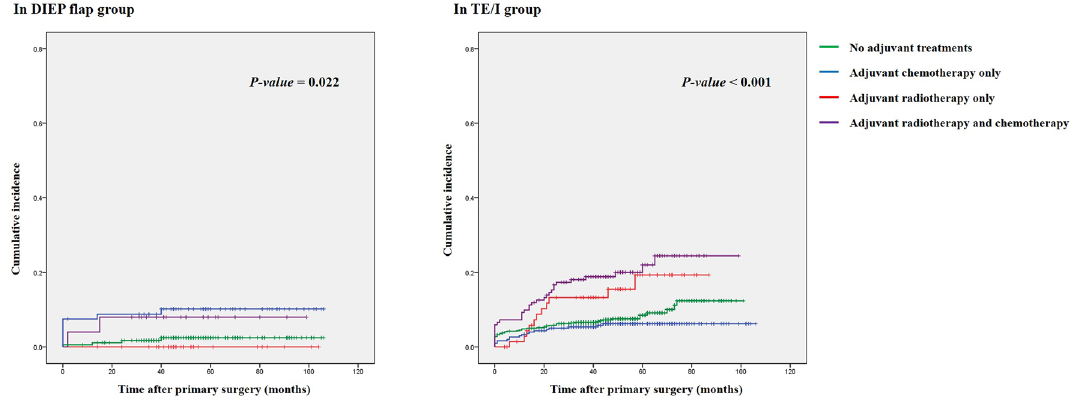
Figure 3. Cumulative incidence of major complications in the (left) deep inferior epigastric perforator (DIEP) and (right) tissue expander/implant (TE/I)